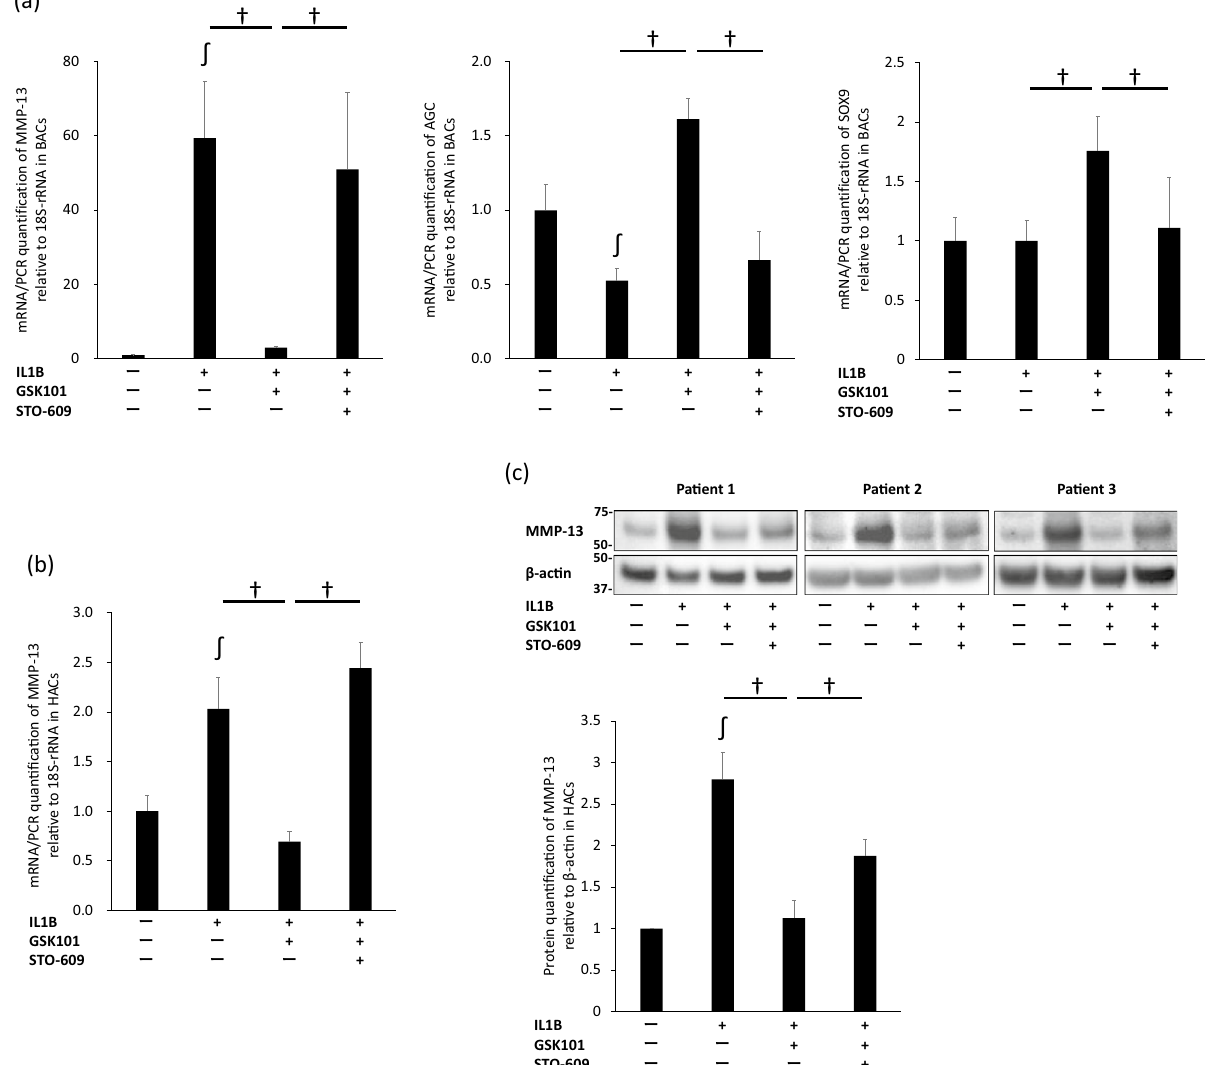
Figure 4. Inhibition of IL-1β-induced cartilage damage via the TRPV4/CaMKK pathway. ( a ) Real-time PCR analysis of relative expression of MMP-13, AGC and SOX9 in BACs treated with IL-1β, GSK101, and STO-609 for 12 h. Pre-treatment with STO-609 canceled the suppressive effect of GSK101 on IL-1β-induced up-regulation of MMP-13 and down-regulation of AGC mRNA. Pre-treatment with STO-609 also canceled the suppressive effect of GSK101 on up-regulation of SOX9 mRNA. ( b ) Real-time PCR of relative expression of MMP-13 in HACs treated with IL-1β, GSK101, and STO-609 for 12 h, and ( c ) Western blot analysis of relative expression of MMP-13 in HACs treated with IL-1β, GSK101, and STO-609 for 48 h. ( b ), ( c ) showed that pre- treatment with STO-609 canceled the suppressive effect of GSK101 on IL-1β-induced up-regulation of MMP- 13 mRNA and protein. Each experiment was repeated three times. Each group of the membrane associated with MMP-13 and the membrane associated with β-actin were different while their protein samples were the same. ∫ p < 0.05 compared to untreated control; † p < 0.05 using one-way ANOVA with Tukey’s test. BAC: bovine articular cell; CaMKK: calmodulin-dependent protein kinase kinase; HAC: human articular